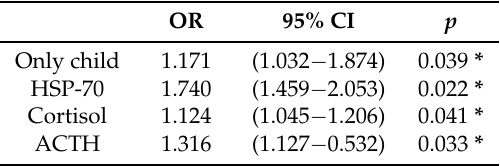
Table 3. Multivariate analysis of job burnout in soldiers stationed in the arid desert. OR 95% CI p Only child 1.171 (1.032 ´ 1.874) 0.039 * HSP-70 1.740 (1.459 ´ 2.053) Cortisol 1.124